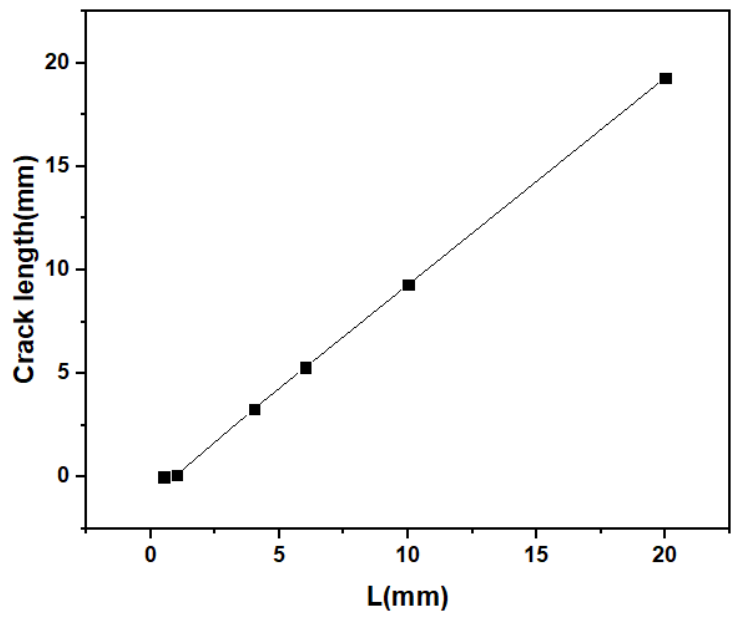
Figure 9. Crack growth under different crack spacing between two vertical cracks.